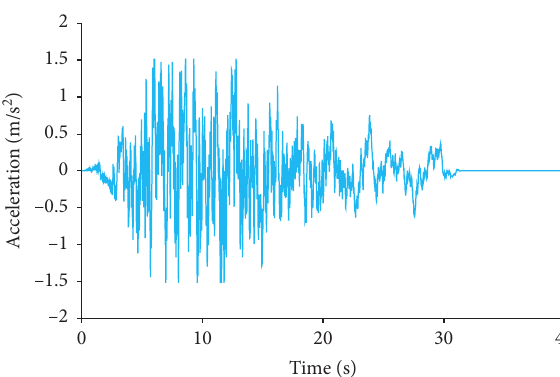
Figure 4: Ground acceleration record (adopted from “Fujian